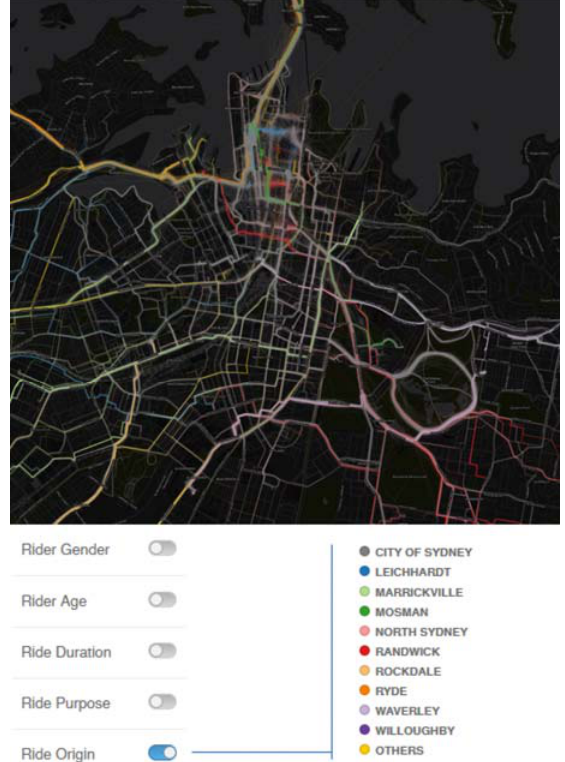
Figure 7. Sydney Area Rider Routes by Ride Origin